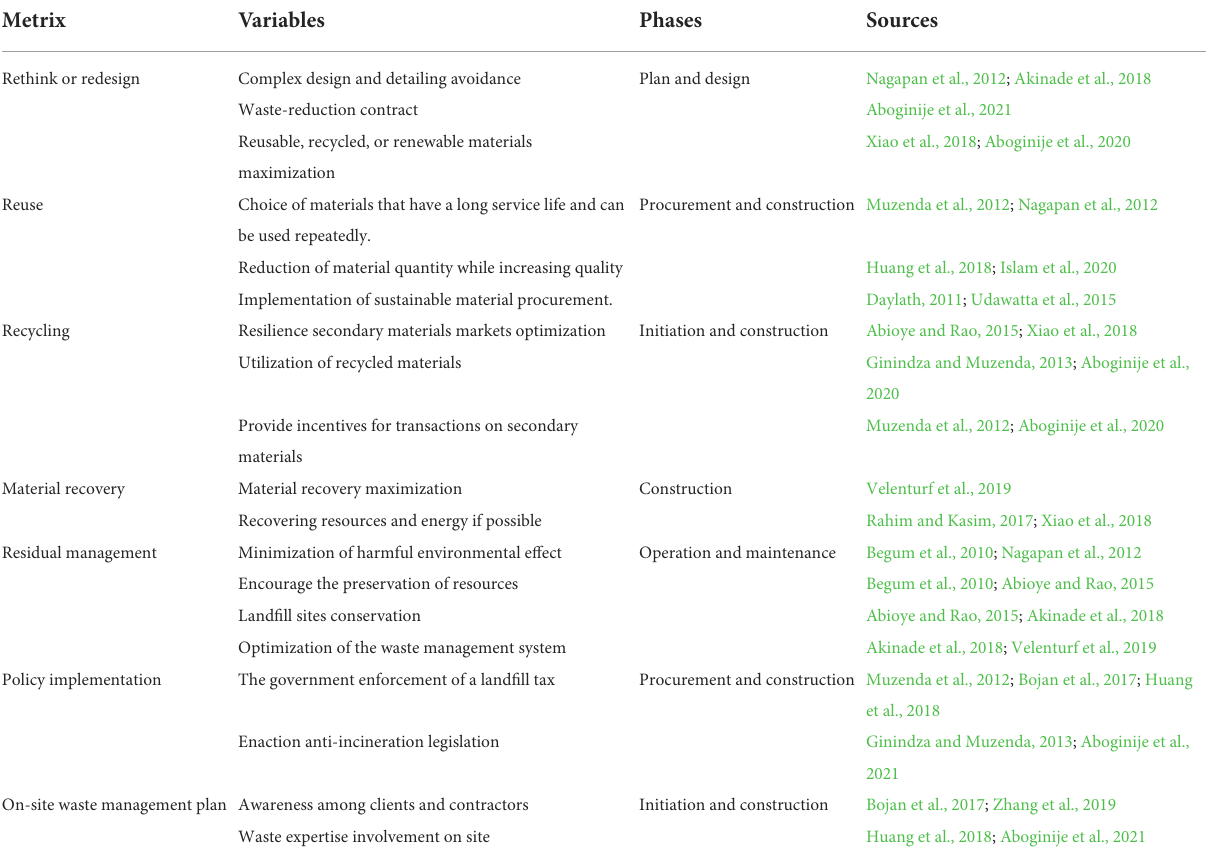
TABLE 1 Criteria for assessing the performance of WMS (Aboginije et al., 2020).